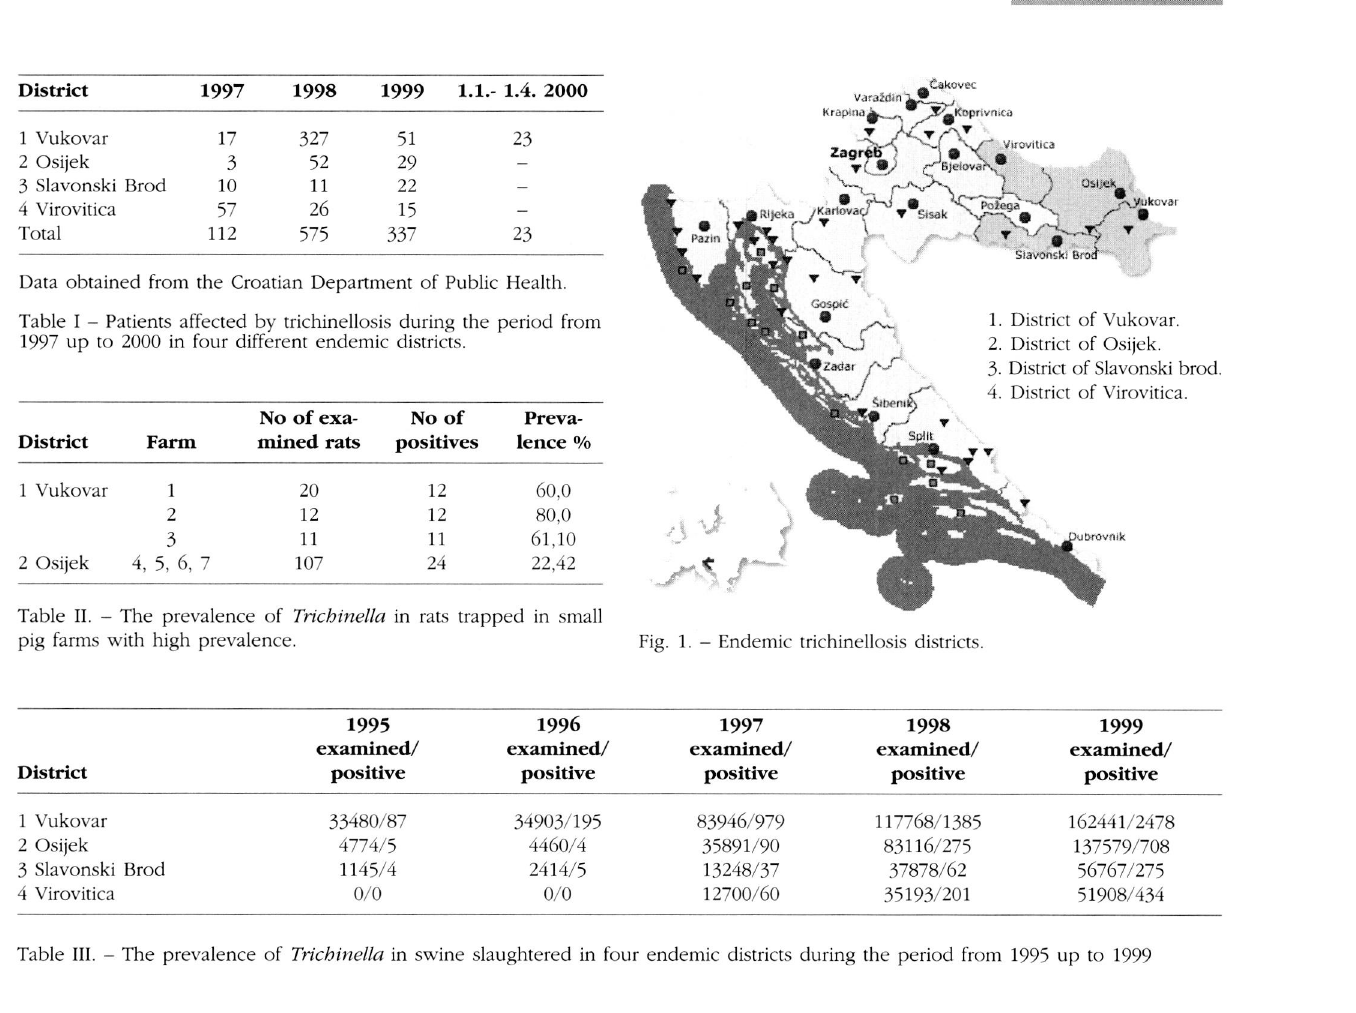
Among rats trapped in seven farms a very high pre valence rate of the parasite was registered (Table II). In one farm (No 2), 80.0 % of rats were found infected. Some of them harboured more than 200 larvae per gram of musculature (data not